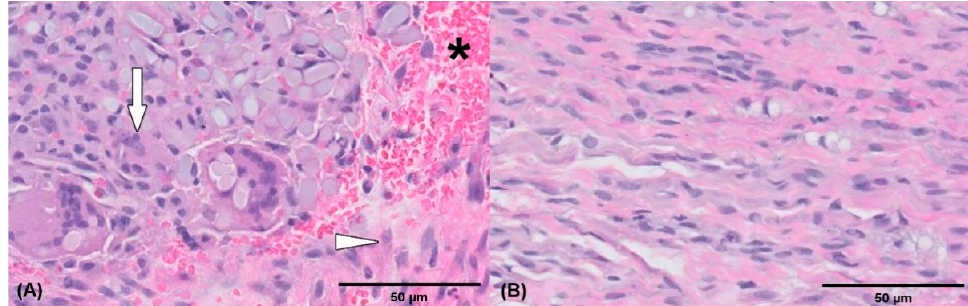
Figure 4. Histological pictures of the injured debrided sciatic nerve tissue ( A , B ). Extensive fibrosis (arrowhead) is present and partially surrounds the nerve. Multifocal axonal degeneration (arrow) and hemorrhage (asterisk) are also noted. Hematoxylin and eosin stain (actual magnification, 50× ( A ), actual magnification, 400×, ( B )).